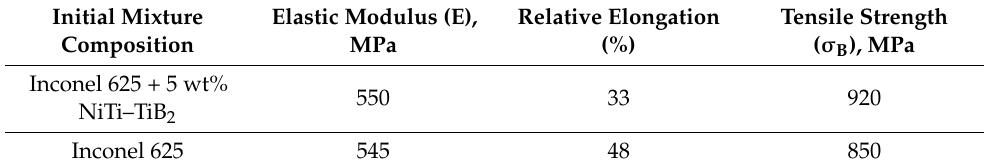
Figure 5. ( a ) Diagram of specimens for stress testing; ( b ) stress–strain diagram obtained during tensile testing of samples obtained by the deposition of a powder mixture of 95 wt% Inconel 625 + 5 wt% NiTi–TiB 2 powder mixture, as well as from testing the samples deposited from pure Inconel 625. Table 4. Tensile test results for materials produced by selective laser deposition.